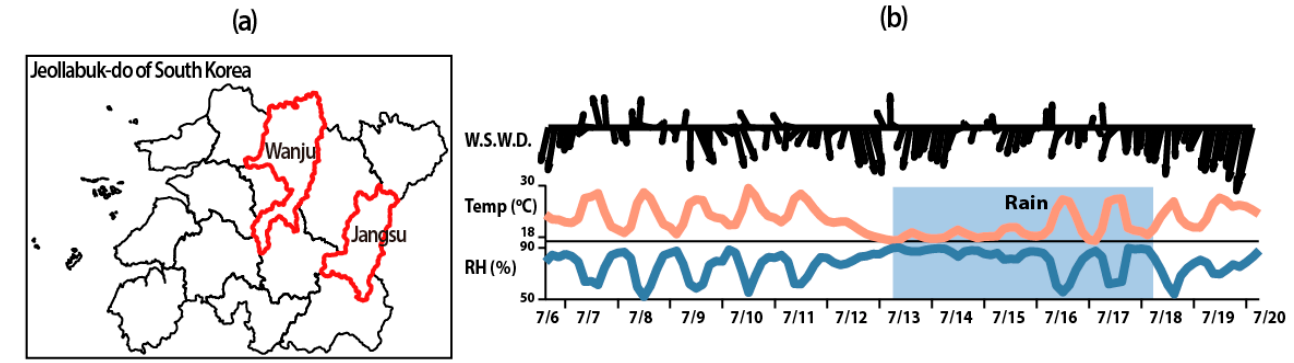
Figure 1. ( a ) Sampling site at Jangsu-gun, Jeollanamdo. ( b ) Meteorological conditions during the sampling periods.